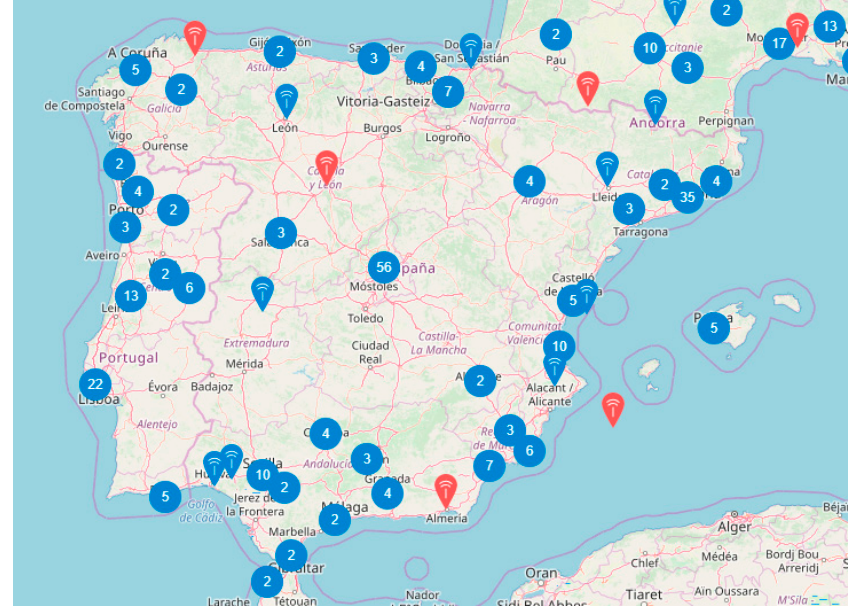
Figure 3. Gateways assigned to TTN in Spain. Source: [30].